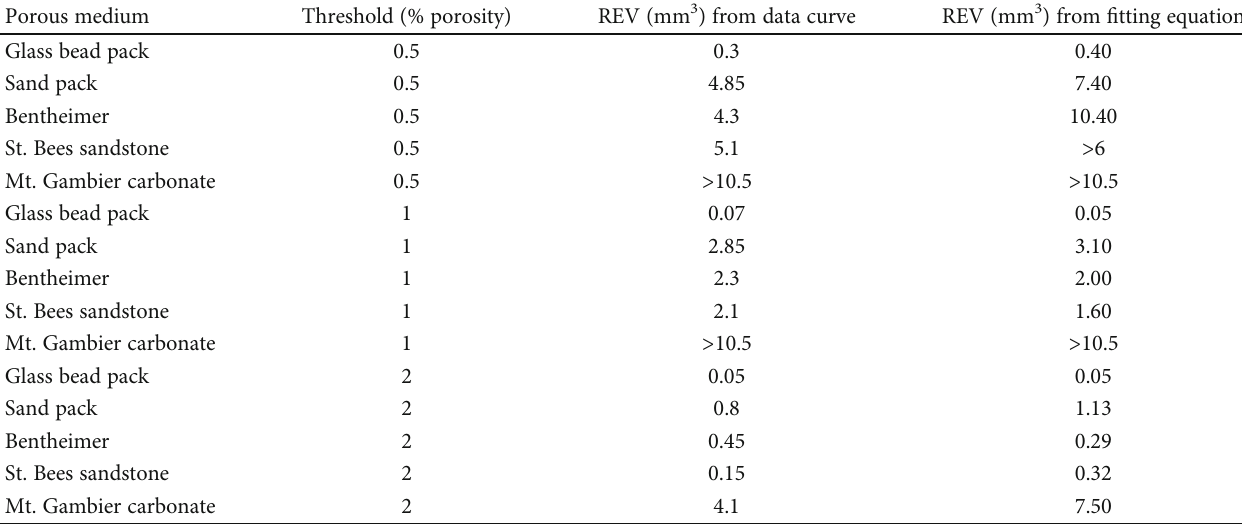
Table 5: In fl uence of threshold value on REV, standard deviation technique. Associated equations are listed in Table 4. Porous